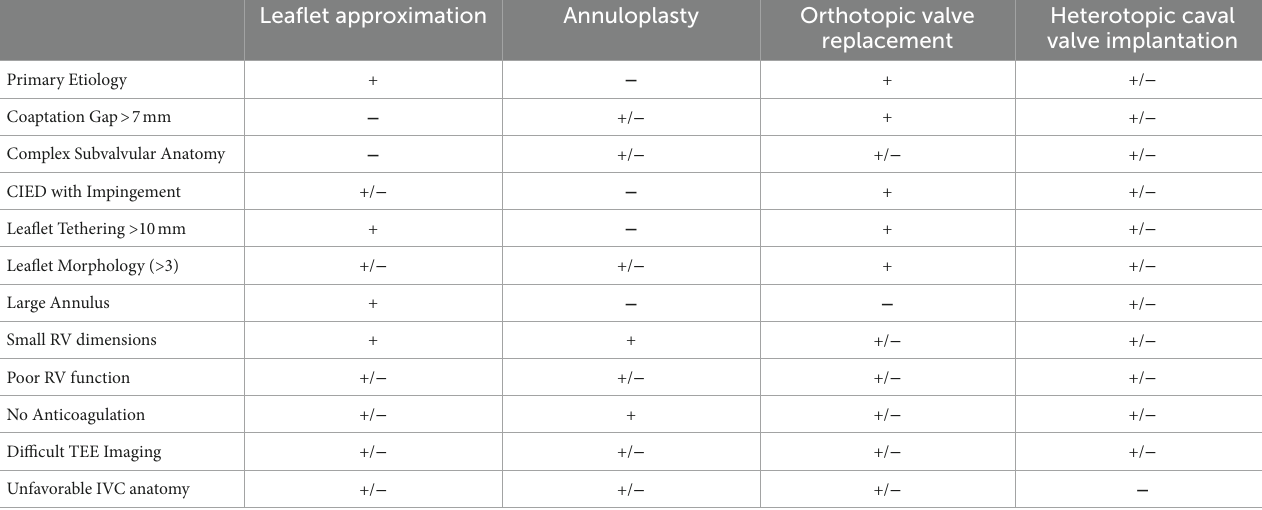
TABLE 1 Considerations when choosing type of transcatheter therapy for tricuspid